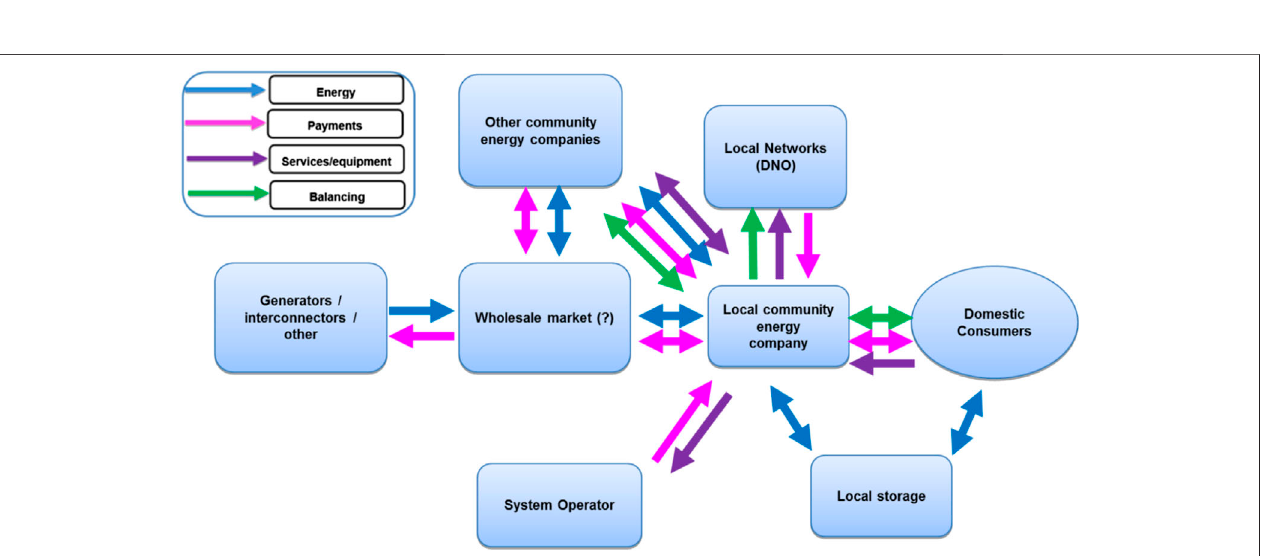
FIGURE 2 | Shared Economy business model archetype.